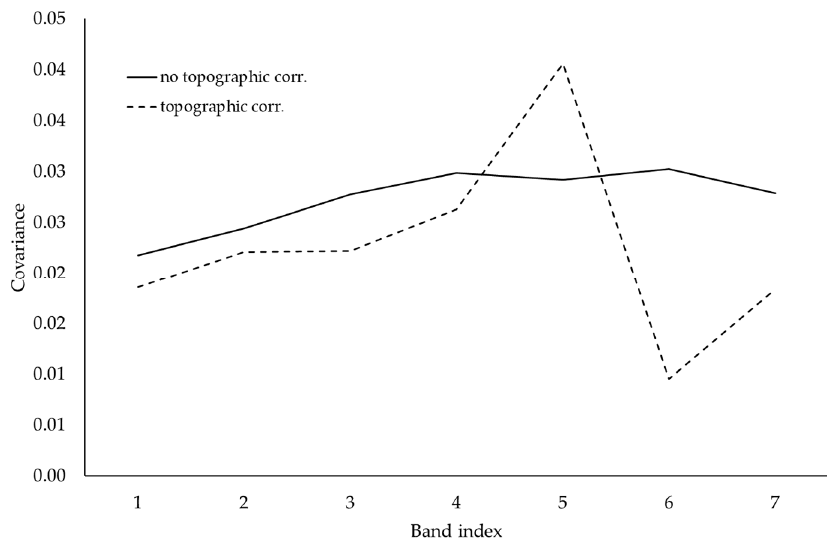
Figure 8. Correlation index between the reflectance image and the sun exposition before (blue line) and after (orange line) the topographic correction.